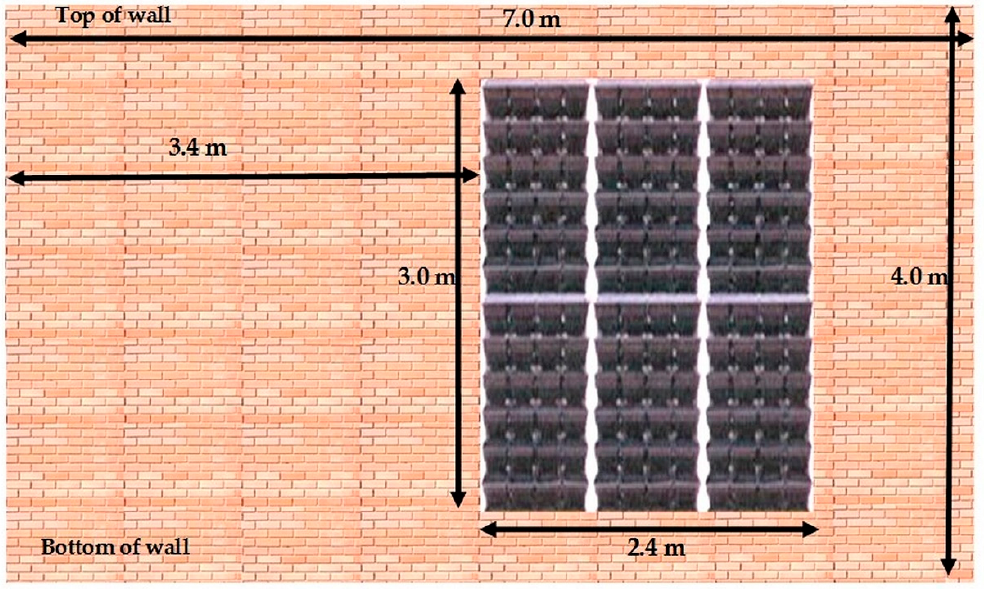
Figure 1. Size and position of the living wall.